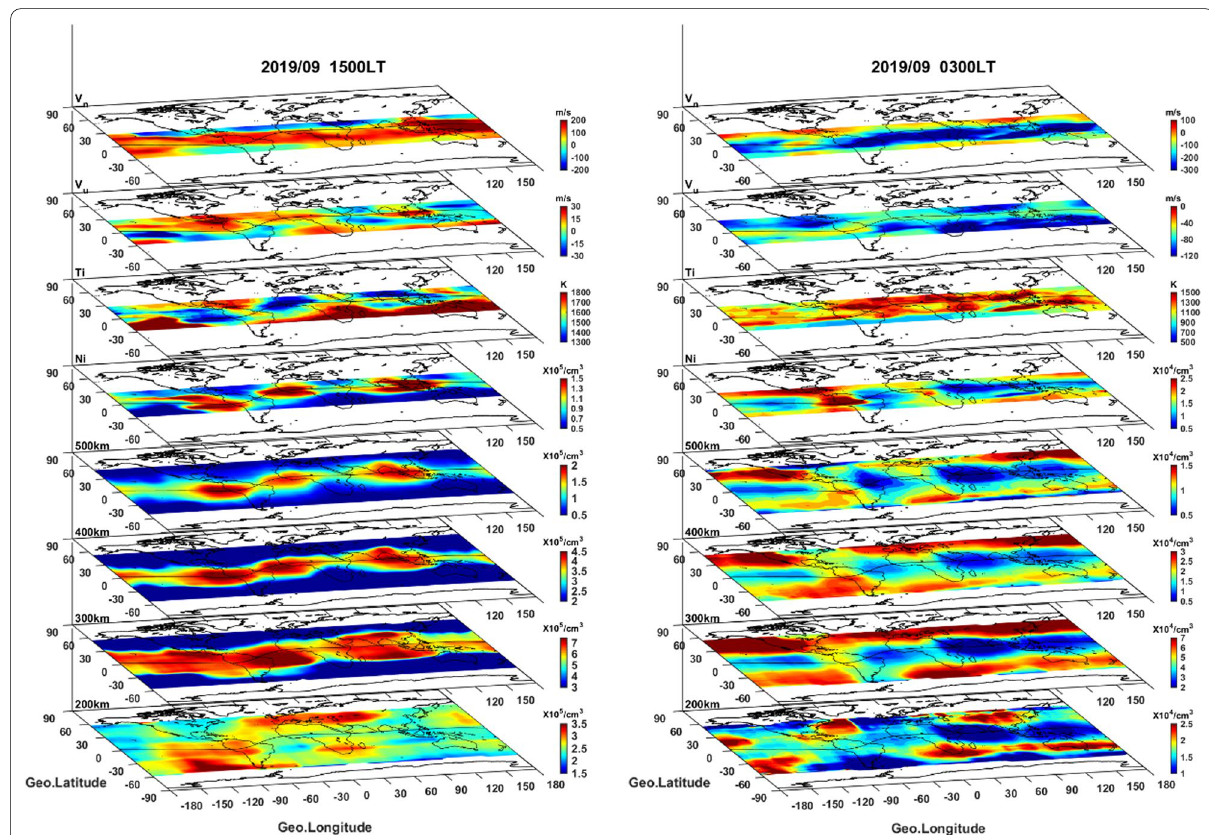
Fig. 18 The TGRS electron density (Ne) as well as the IVM ion density (Ni), ion temperature (Ti) and ion upward (Vu) and northward (Vn) at 1500 LT (right column) and 0300 LT (left column) in September